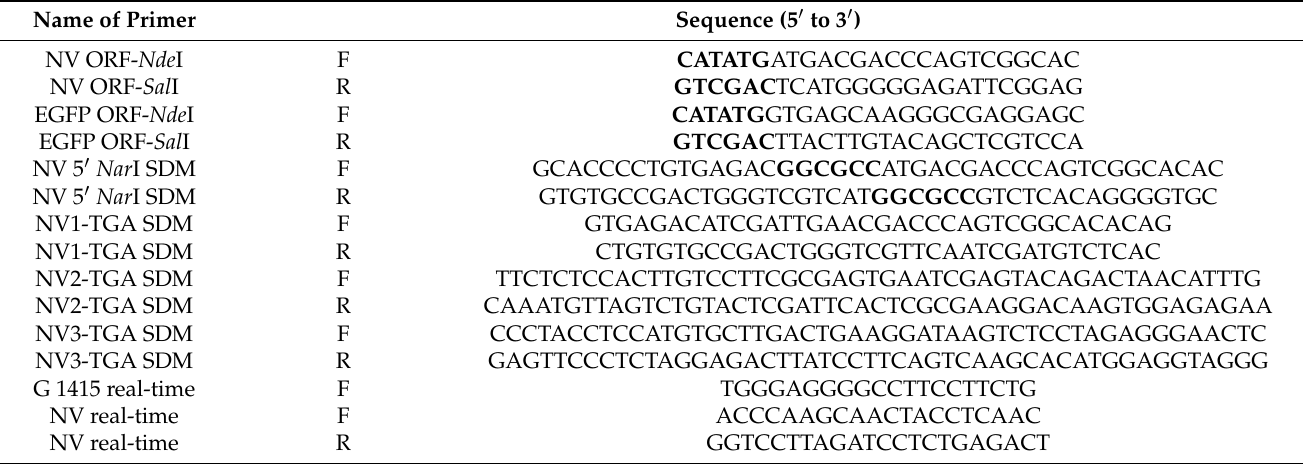
Table 1. Summary of primers used in this study.